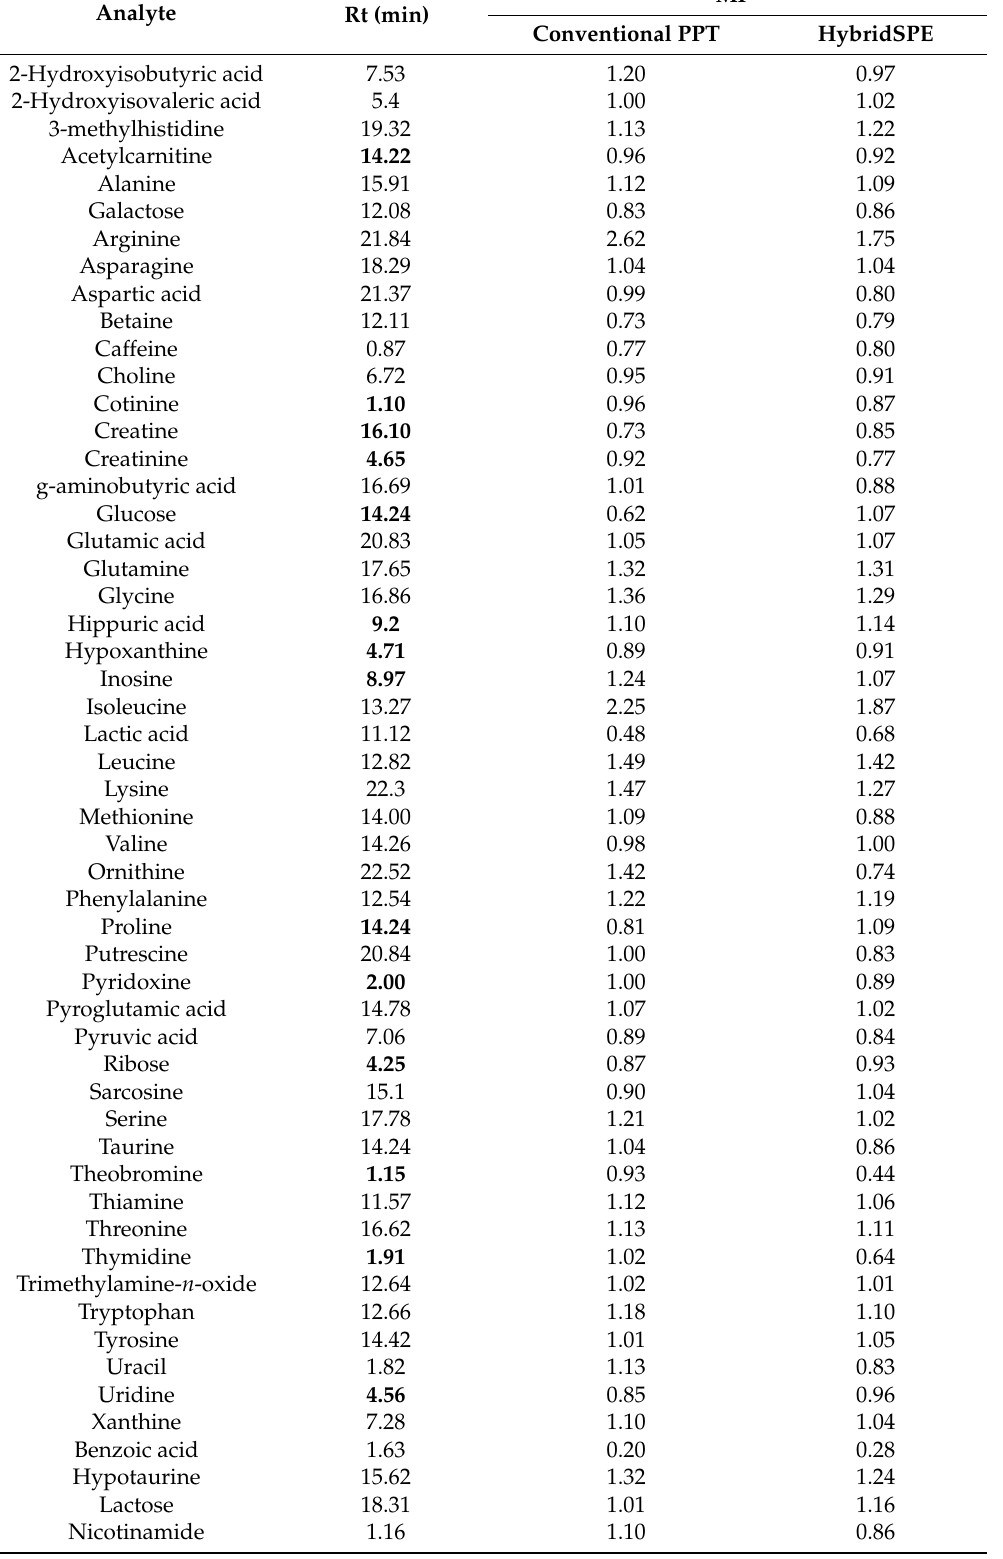
Table 2. Comparison of the final selected HybridSPE protocol with the standard PPT in terms of matrix effect (ME). Retention time of target metabolites in bold indicates elution of analyte in the area of phospholipid elution